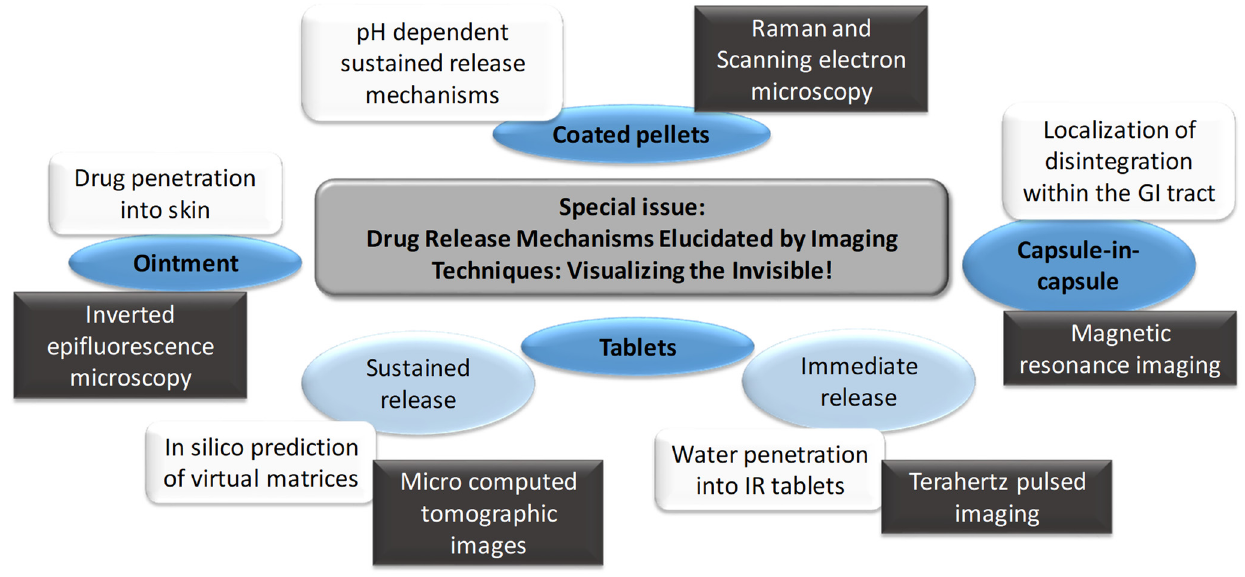
Figure 1. Schematic presentation of the Special Issue’s contents.